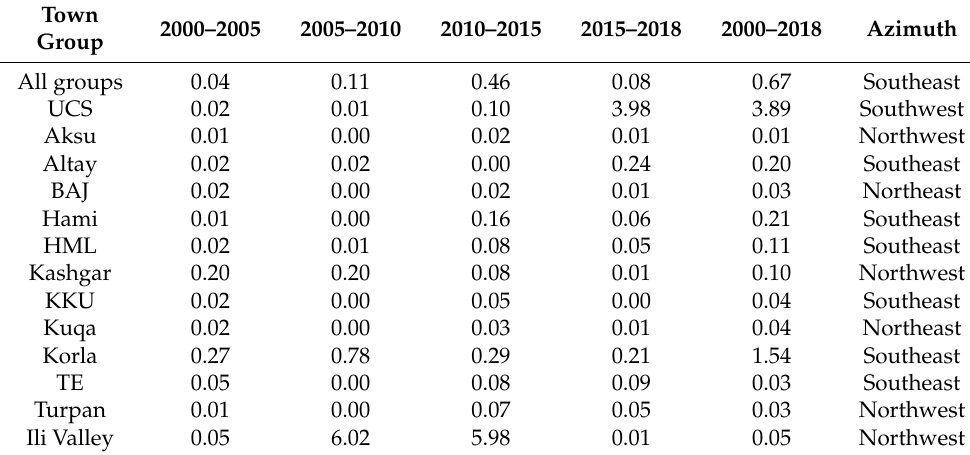
Table 6. The distance (km) and compass direction of shifts in the centers of gravity of construction land in the 13 town groups in five study